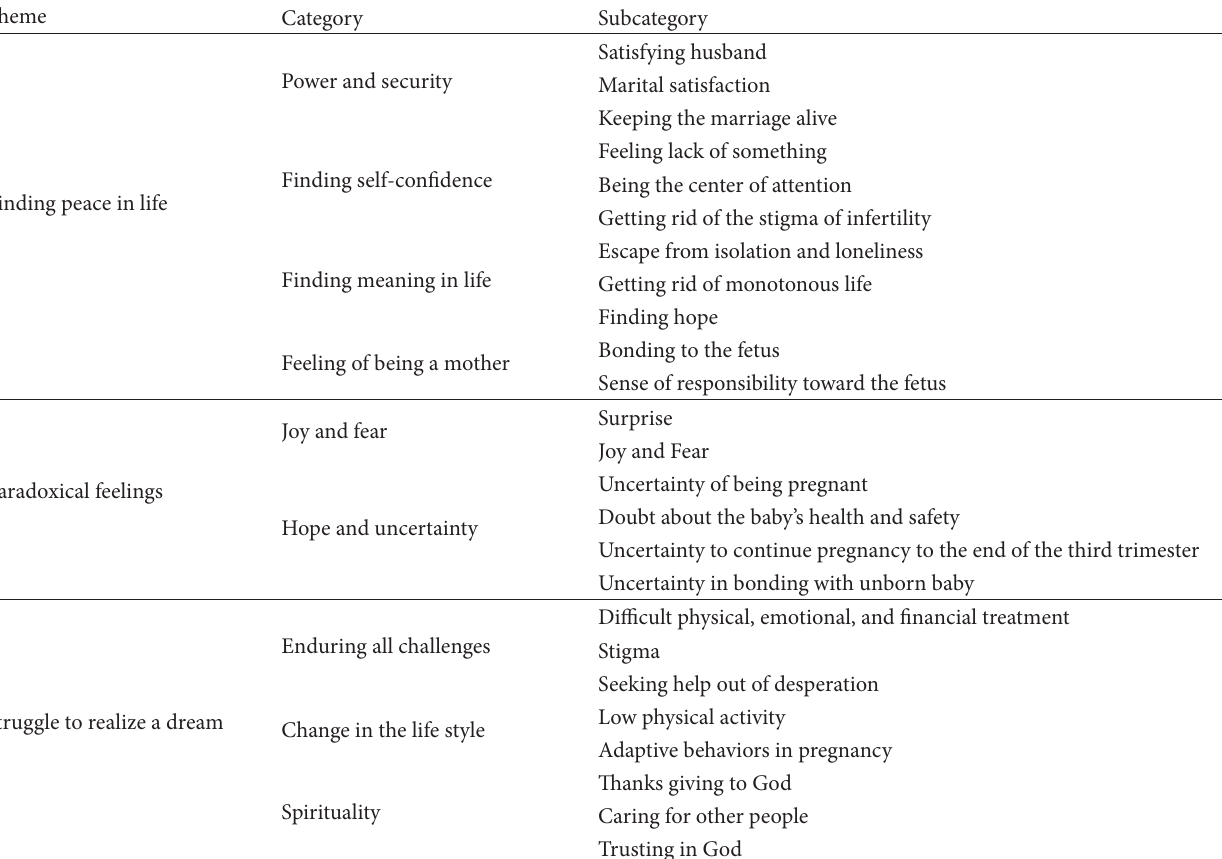
Table 2: Themes arising from women’s perceptions of assisted